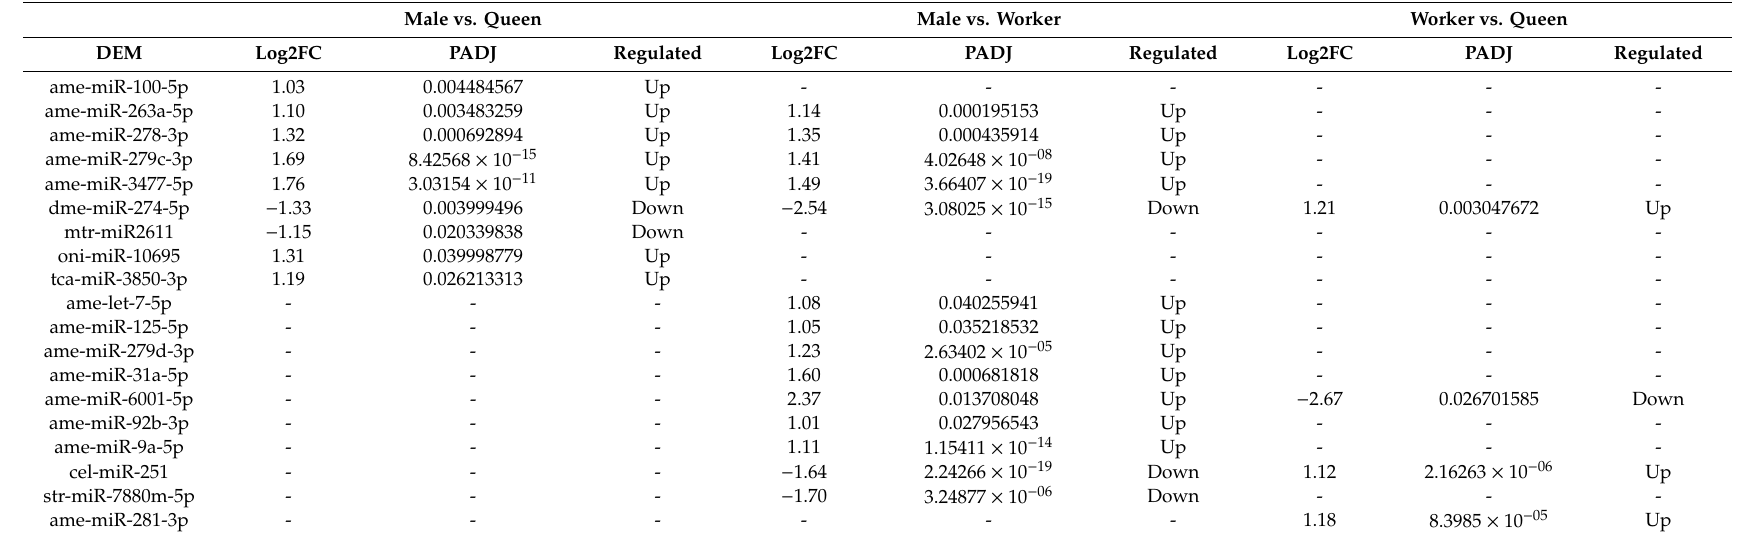
Table 4. Di ff erentially expressed miRNAs in the three castes of B. lantschouensis . Male vs. Queen Male vs. Worker Worker vs.